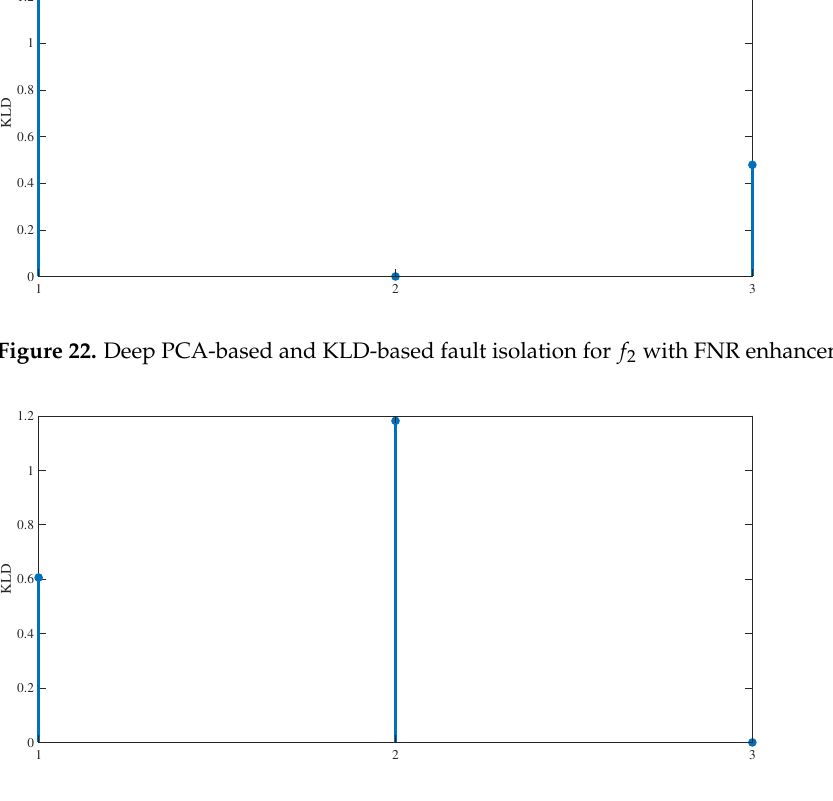
Figure 23. Deep PCA-based and KLD-based fault isolation for f 3 with FNR